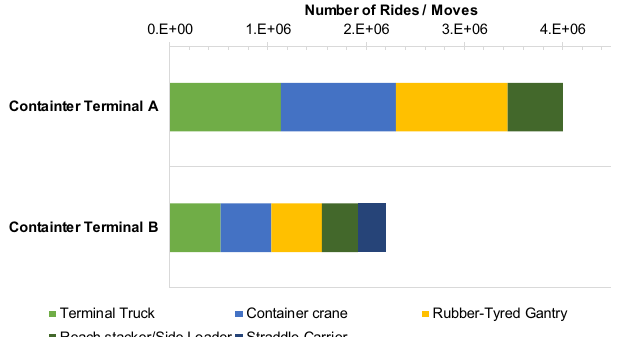
Figure 5. Number of rides on container-handling equipment.